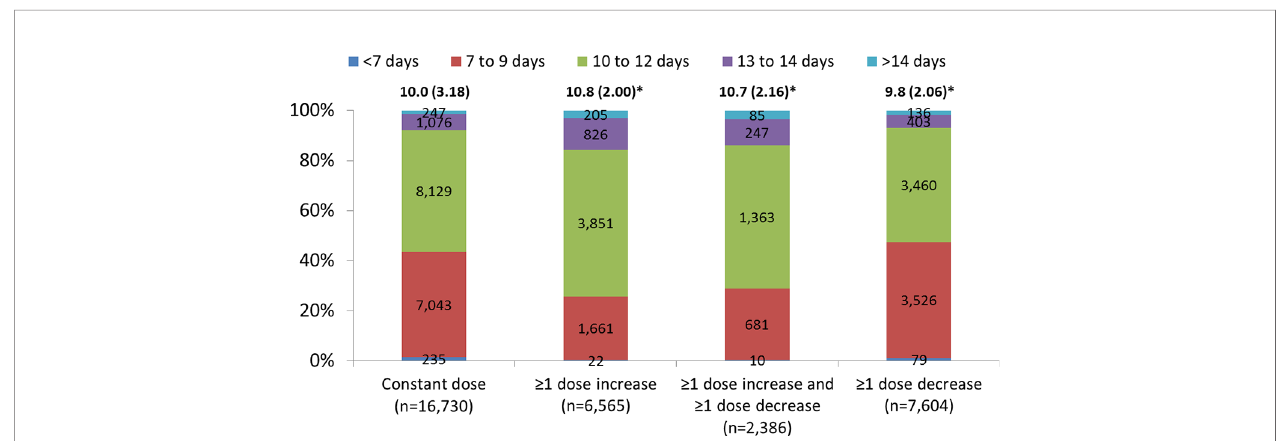
FIGURE 4 | Length of ovarian stimulation (including cancelled cycles). Data are presented as mean (standard deviation) and number and proportion in each dosing category with no missing cycle length. ≥ 1 dose increase includes all cycles with at least one dose increase (regardless of any decrease). ≥ 1 dose decrease includes all cycles with at least one dose decrease (regardless of any dose increase). *p < 0.0001 compared with constant dose. P-values are from models adjusted for differences in age, body mass index, starting dose and other dosing characteristics.